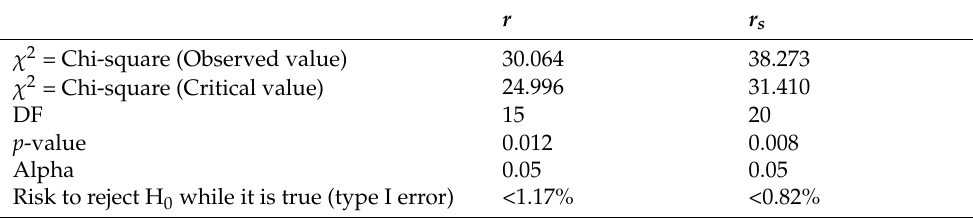
Table 5. Bartlett’s sphericity test results based on Pearson r and Spearman r s correlation